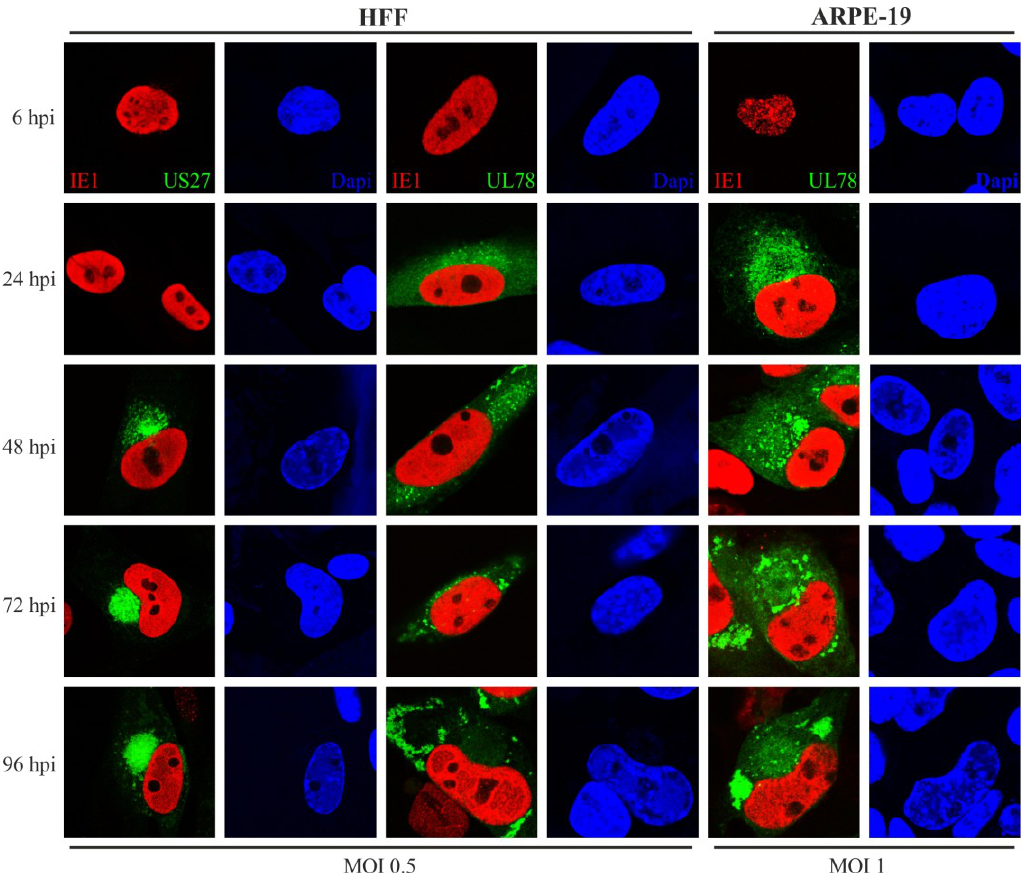
Figure 3. Subcellular localization of US27-EYFP and UL78-EYFP in infected HFFs and ARPE-19 cells. HFF (left and middle panel) or ARPE-19 cells (right panel) were infected with recombinant TB40/E viruses (MOI: 0.5 or 1) expressing fusion proteins of pUS27 (left panel) or pUL78 (middle and right panel) with EYFP and fixed at different time points during HCMV infection (6–96 hpi). Cells were stained with primary antibody mAb-IE1 (p63-27), and a secondary anti-mouse antibody coupled to Alexa-555. Cell nuclei were stained with